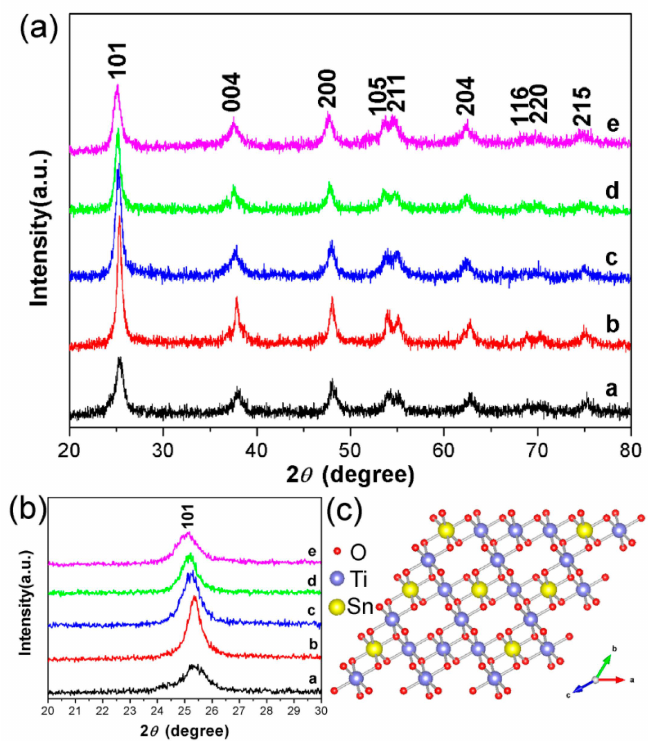
Figure7. ( a )TheXRDofTiO 2 hierarchicalnanospheres(24h)(curvea)andSTOhierarchicalnanospheres with di ff erent molar ratios of n Sn / n Ti : 1% (curve b), 5% (curve c), 10% (curve d), and 15% (curve e). ( b ) The corresponding XRD magnification image in the range of 2 θ = 20 ◦ –30 ◦ . ( c ) Atomic structure model for the STO hierarchical